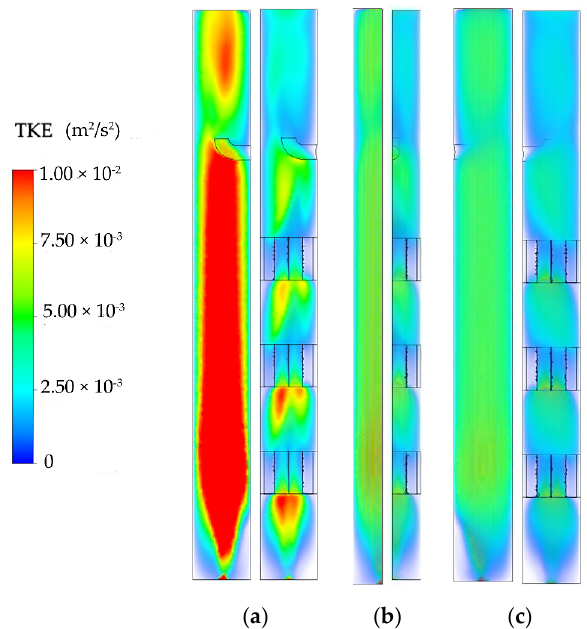
Figure 7. Turbulent kinetic energy (TKE) distribution characteristics in UFC and PFC: ( a ) Front view; ( b ) Sside view; ( c ) Rear view.